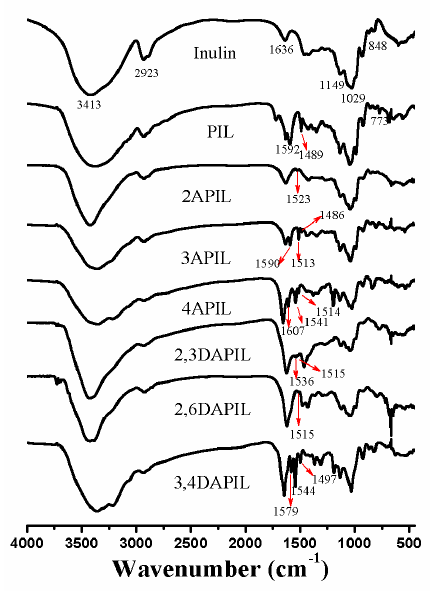
Figure 1. Fourier Transform Infrared Spectroscopy (FT-IR) spectra of inulin and cationic inulin derivatives.